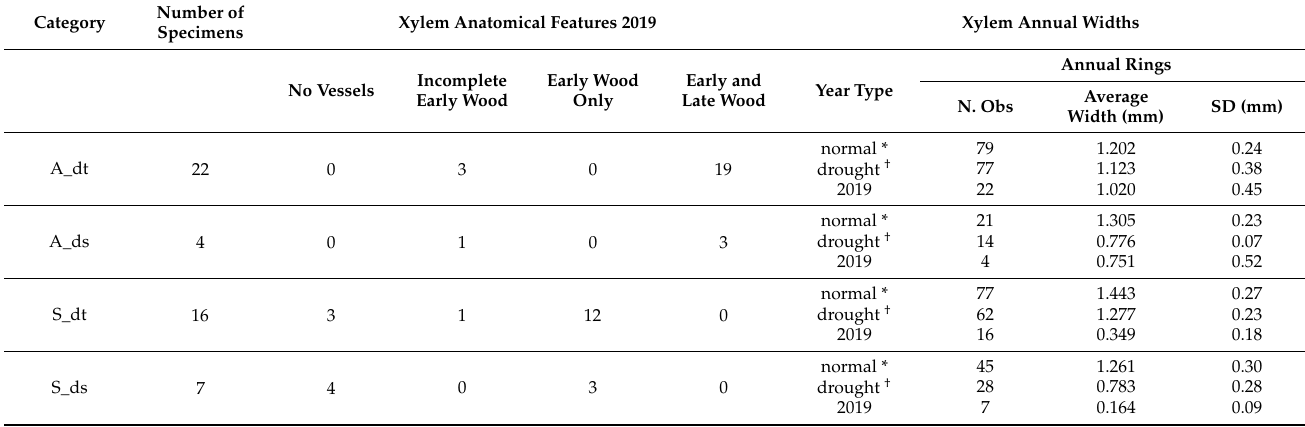
Table 2. Xylem anatomical features in 2019 and average annual ring width according to the four main categories of asymptomatic drought-tolerant (A_dt), asymptomatic drought-sensitive (A_ds), symptomatic drought-tolerant (S_dt), and symptomatic drought-sensitive (S_ds) in normal climatic years, in drought years, and in 2019. Number of observed and analysed rings per year type: N. Obs; standard deviation: